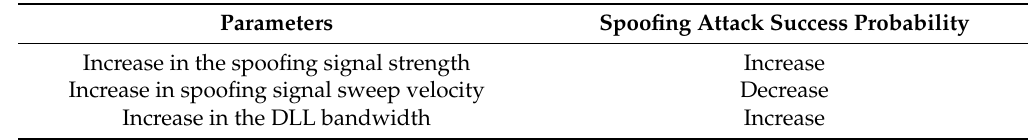
Table 1. Relationship between spoofing parameters and spoofing